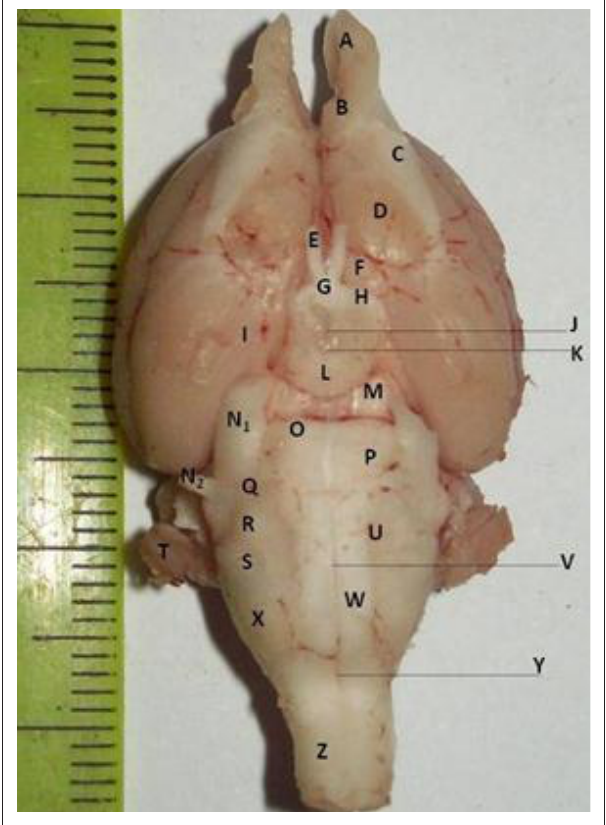
FIGURE 2: Ventral view of the brain of the African giant pouched rat. FIGURE 3: Dorsal view of the brainstem of the African giant pouched